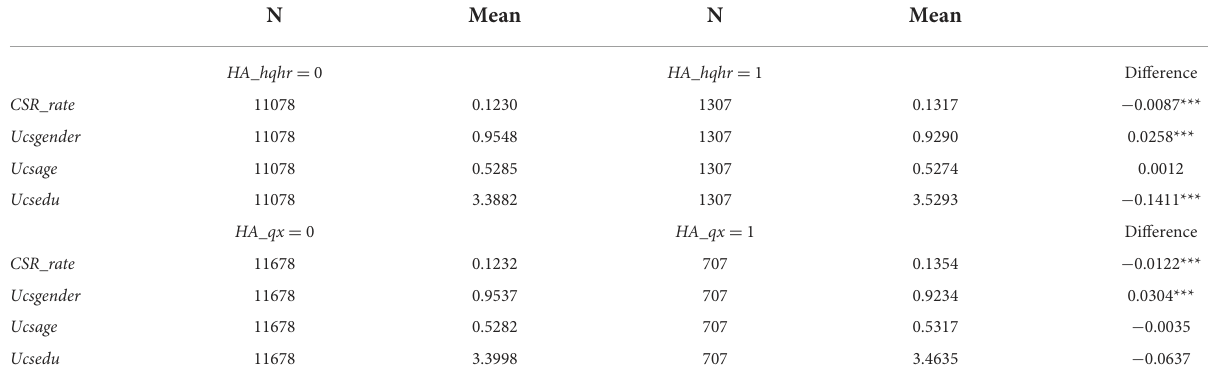
TABLE 4 Univariate